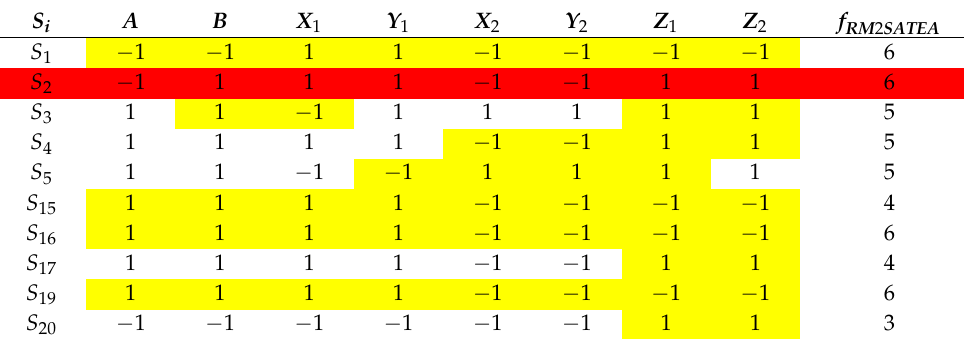
Table A13. Coalition of Party 1 and Party